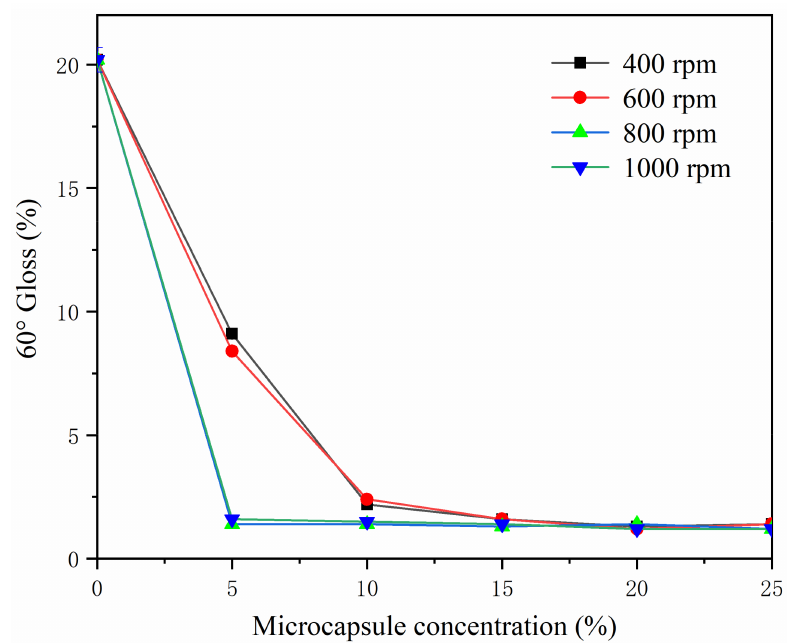
Figure 6. Effect of microcapsules on the gloss.